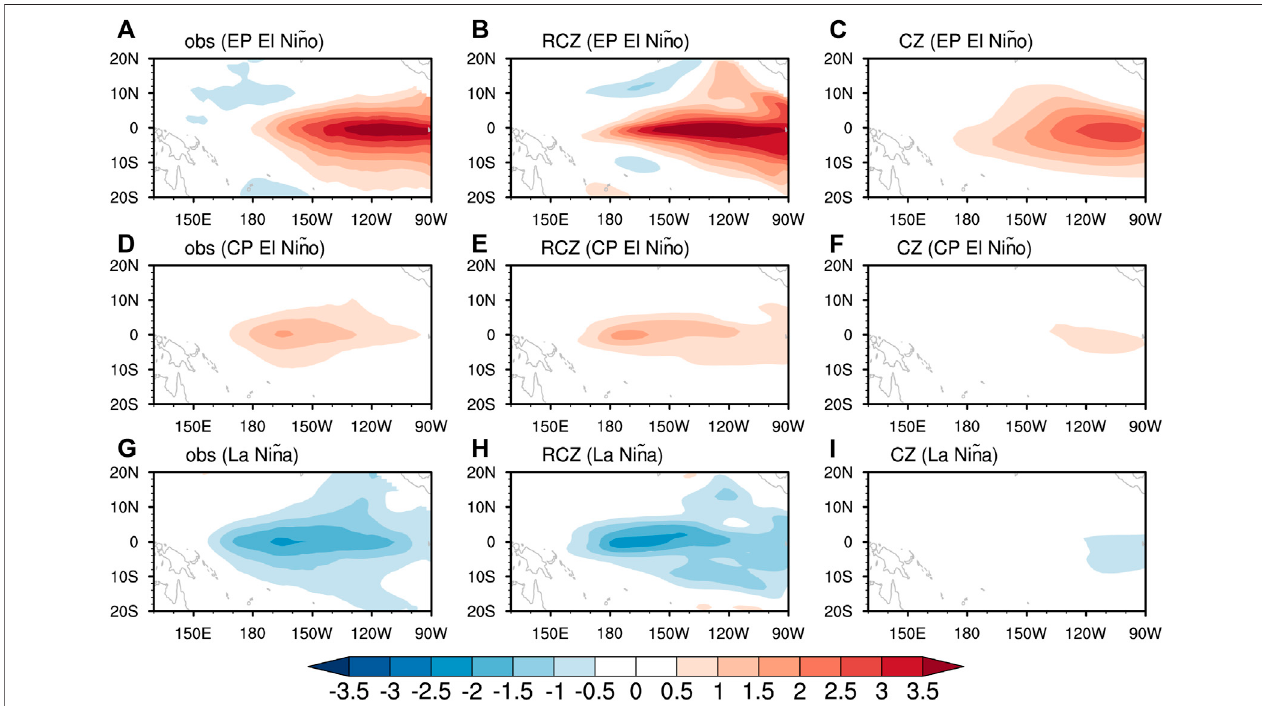
FIGURE9| CompositedNovember-December-January (NDJ)averageSSTA(shading; unit: ° C)associatedwithEPElNiño,CPElNiño,andLaNiñain (A,D,G) the observations, (B,E,H) the RCZ oceanic component simulation, and (C,F,I) the CZ model oceanic component simulation. EP El Niño, CP El Niño, and La Niña years are selected as in Figure 6 .